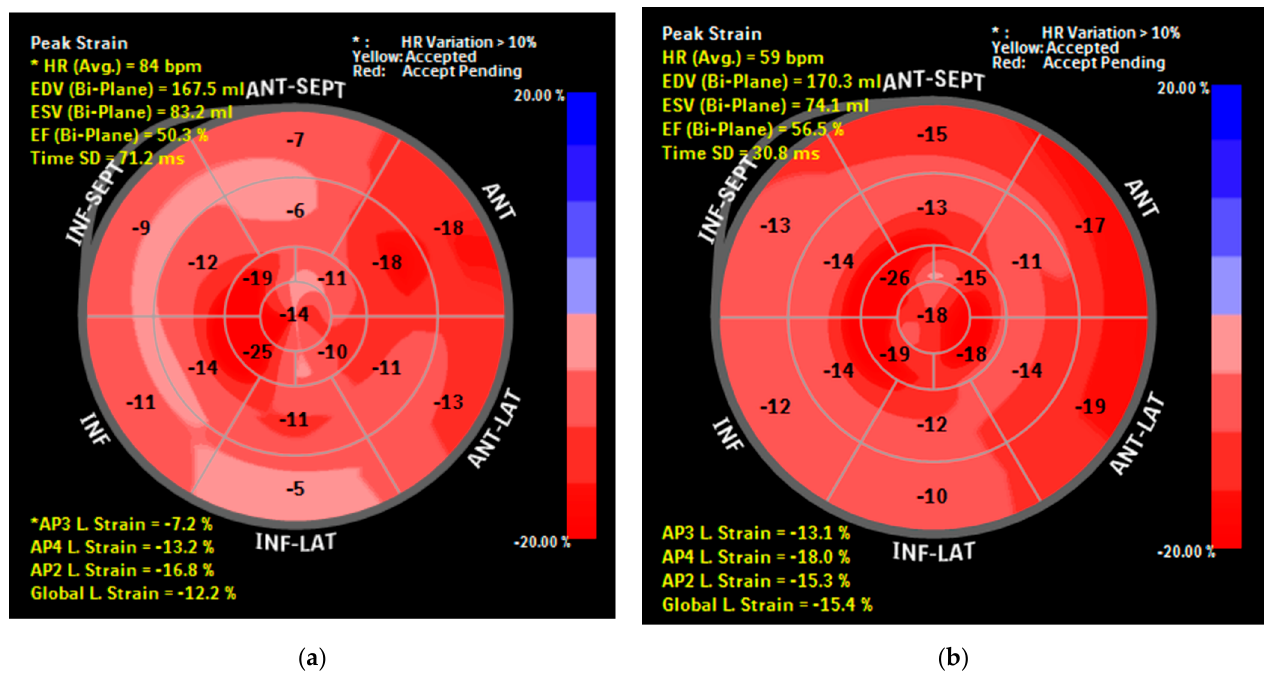
Figure 2. ( a ) Bull’s Eye diagram of LV-GLS before CPAP (patient G.C.); ( b ) Bull’s Eye diagram of LV-GLS after 8 weeks of CPAP (patient G.C.). Table 3. Comparison of clinical and echocardiographic parameters in our study group, before and after 8 weeks of CPAP.